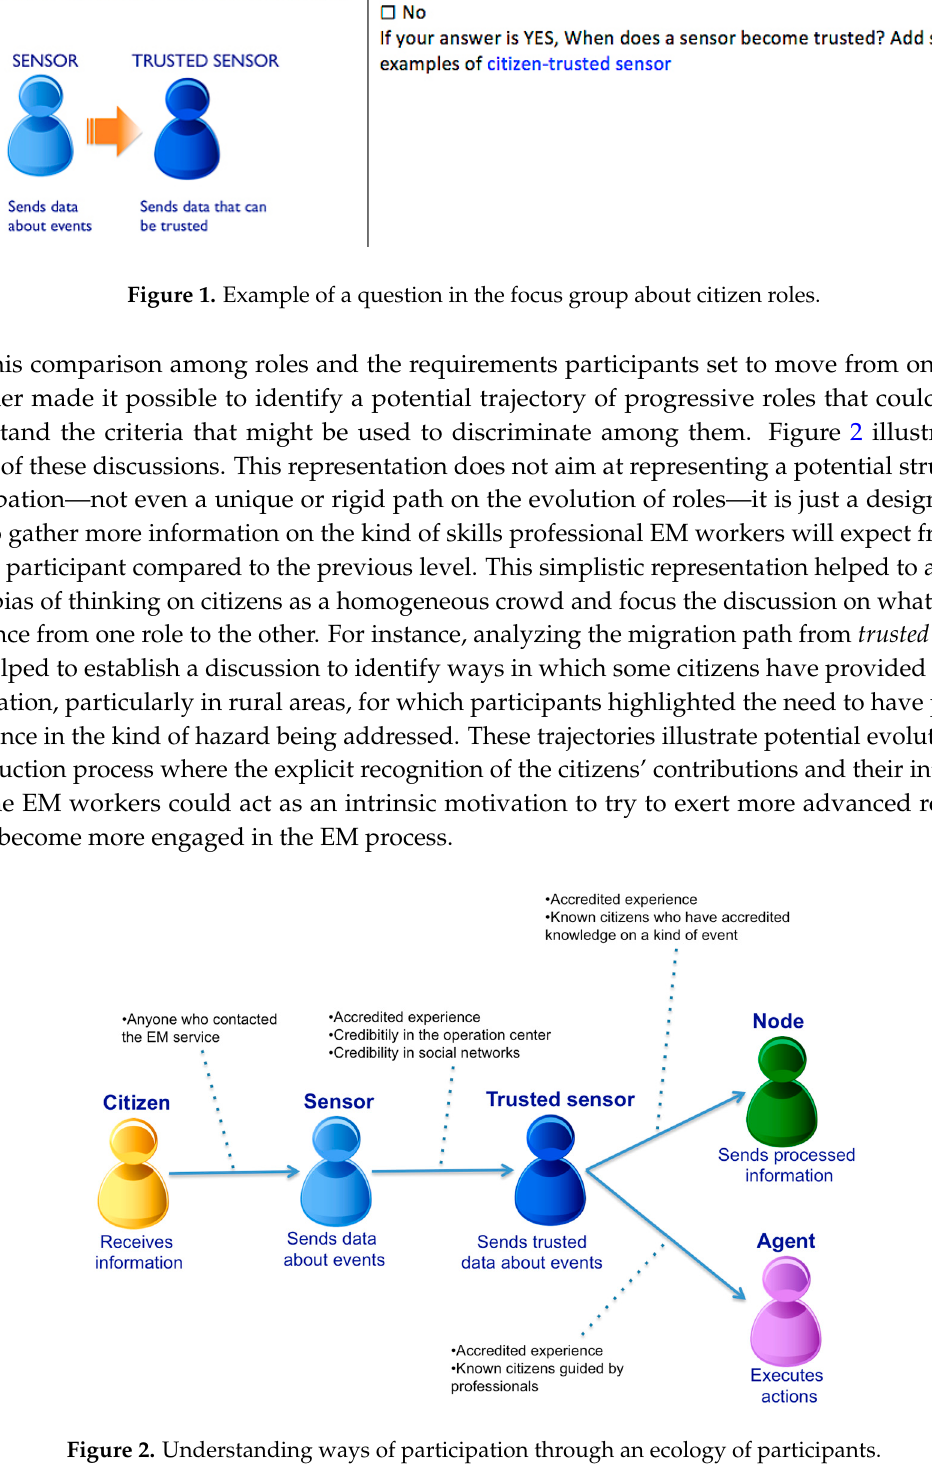
Figure 2. Understanding ways of participation through an ecology of participants.